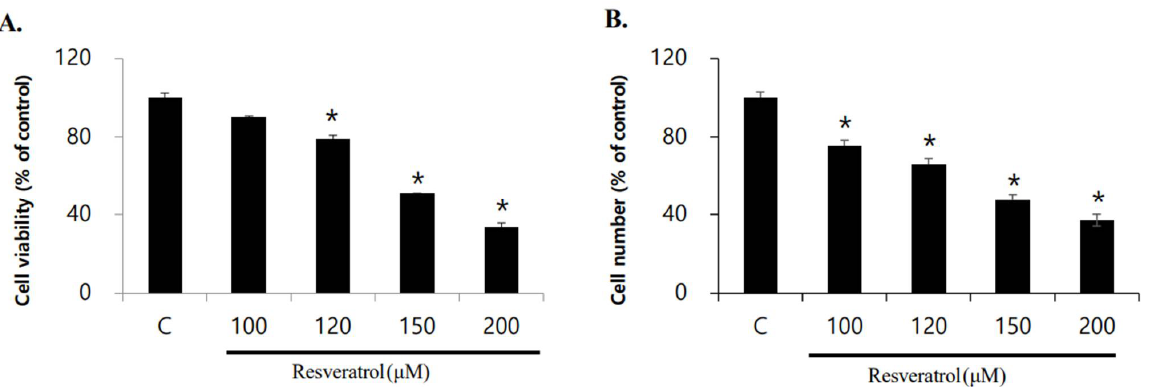
Figure 1. Inhibition of WPMY-1 cell proliferation by resveratrol treatment. The cells were treated with various resveratrol concentrations (0, 100, 120, 150, and 200 μM) for 24 h. ( A ) Cell viability was determined by MTT assay. ( B ) The cells were counted by hemocytometer and microscope. The data are expressed as mean ± SD as a result of three independent experiments depending on the resveratrol concentration (* p < 0.05).